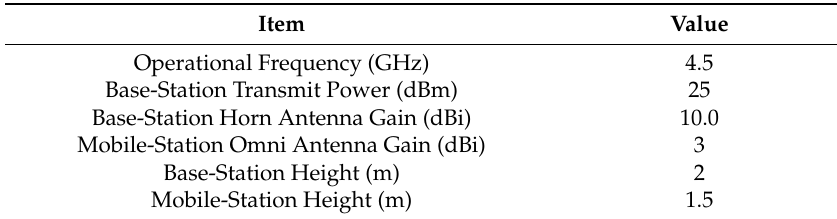
Table 2. Measurement assessment